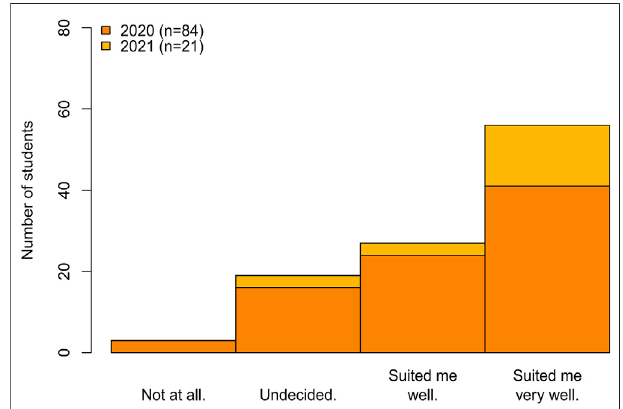
FIGURE 4 | Answers to the question “ How well did it suit you that the excursion took place in Zurich? ” . It suited the majority of the students well or very well that the excursion took place in Zurich (results from the survey sent out directly after the